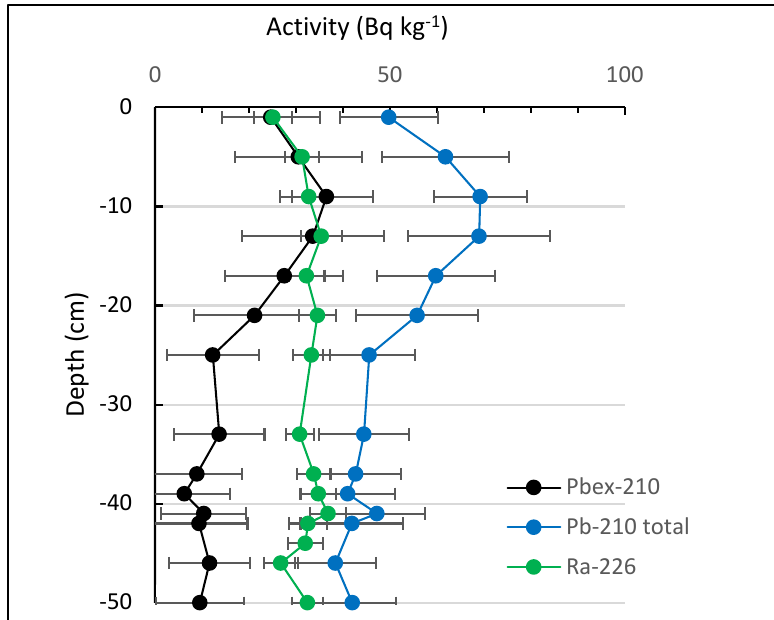
Figure 7. Depth profile of 210 Pb total , 226 Ra and 210 Pb excess in the core sediment of the Limoncocha lagoon. Therefore, the first 9 cm can be made of a different material than the rest of the core. Most of the elements have the same evolution as the radionuclides with a decrease in con- centration from −1 0 cm to the surface of As, Ba, Co, Cr, Cu, Mo, Ni, Pb, V and a decrease from −2 0 cm of Cd and Zn (Figure 4). There may have been a continuous phenomenon that has taken place cyclically with other material (the profile is descending and not flat), caused probably by the groundwater connections between the Napo River and the Limoncocha lagoon. After relevant flooding events, every approximately 2 years, the wa- ters of the lagoon rise about three meters, but without flooding the lagoon as in previous periods, recovering the level of the water to its normal state. Several reasons can be put forward for that behavior. On the one hand, the oil infrastructures, mainly highways, have been able to act as screens against possible avenues of the river. On the other hand, the water of the Napo River has decreased in flow, and there have been sandbanks making the river in certain places no longer navigable. As a consequence, when the river flow rises, it drags the sandbanks that accumulate on the banks, acting as containment barriers for the overflow of the river water. Finally, the Lagoon has underground currents that keep the river and Lagoon connected, so that in recent decades, the lagoon ’ s water mirror rises to 3 m above normal, without there being a visible direct connection between the two bodies of water. Jarrin et al. [86] show that in the entire southern part of the lagoon, up to the left bank of the Napo River, the groundwater is less than 5 m deep and may constitute the connection between the river and the lagoon in times of great rains and avenues. These cyclical flooding events, together with bioturbation processes, may have caused remobi- lization and resuspension of sediments, providing the radionuclides and elements profiles obtained. Several authors such as [103 – 108] among others, have discarded the data of the most superficial layers of the cores to obtain the graphical solution of the sediment mass flow. The main arguments put forward by those researchers to justify the presentation and treatment of their data included the invalidity of steady-state accumulation caused by bioturbation, turbulent flow, and sediment core sampling, In the deeper section (39 cm − 50 cm), the 210 Pb excess is constant and everything meas- ured for radionuclides and elements is constant, but not zero. The constant 210 Pb excess would indicate a process of mixing and/or resuspension of the same material so that in those centimeters it is always the same. This final section seems mixed and the balance between 226 Ra and 210 Pb is not reached. Authors such as Mabit et al. [58], San Miguel et al. [109], and Harb [110] indicate similar situations, either because the core is too short to reach the equilibrium depth (depth at which the total 210 Pb is in equilibrium with the